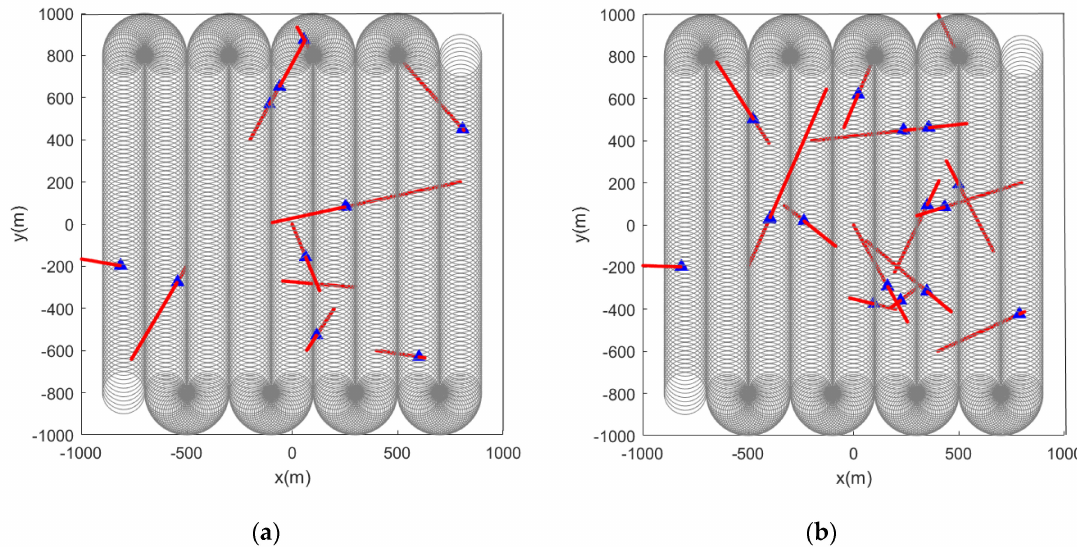
Figure 8. Estimated position of dynamic feature points using the LMB algorithm (the red track is the feature point motion track; the blue marks indicate the estimated positions of the feature points in the scene). ( a ) Sensor detection radius is 100 m, there are 10 feature points in the scene, and the red track is the feature point motion track; ( b ) sensor detection radius is 100 m, there are 15 feature points in the scene, and the red track is the feature point motion track.